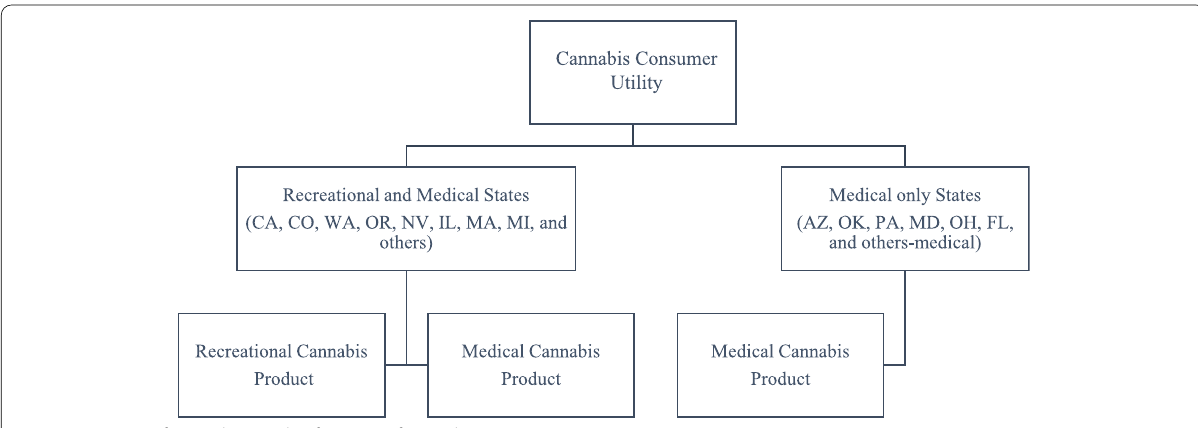
Fig. 1 Structure of nested CES utility function of cannabis consumers